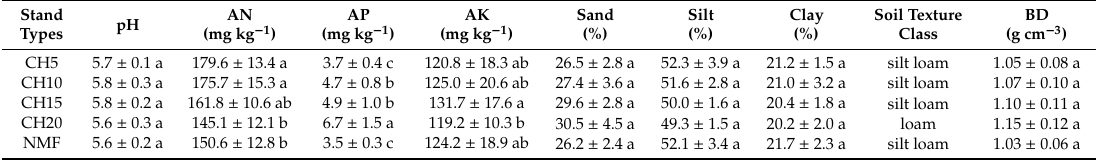
Table 2. Physical and chemical properties of soils (0–20 cm) in Chinese hickory stands managed intensively for 5, 10, 15, and 20 years, and in Chinese hickory–broad-leaved mixed forest. Stand